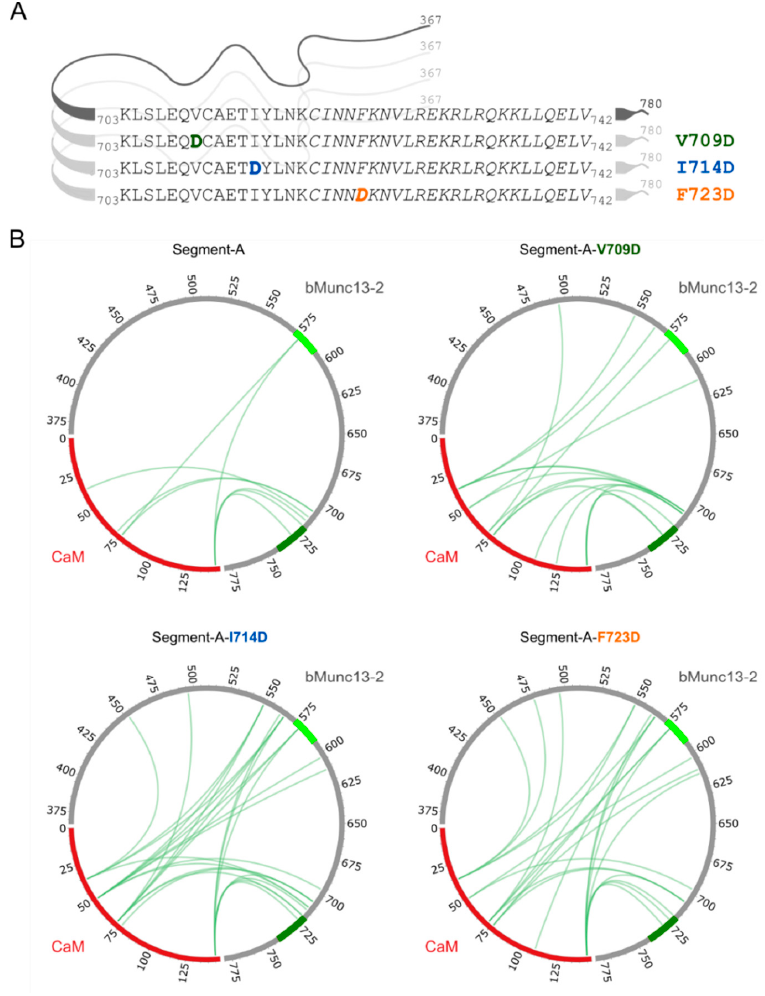
Figure 7 . Segment-A variants and photo-Met cross-linking with CaM. ( A ) Segment-A variants (V709, I714 and F723) were generated by exchanging hydrophobic amino acids to aspartic acid (bold, colored letters). Displayed are the amino acid sequences of the previously employed segment-C, in which the proposed CaM binding region is shown in italics. ( B ) Cross-links observed with photo-Met for wild-type and segment-A variants (750 nM Ca 2 + ). CaM is highlighted in red; CaM binding sites are colored in light green (predicted site, aa 572–594) and dark green (established site, aa 719–742) within segment-A (gray).